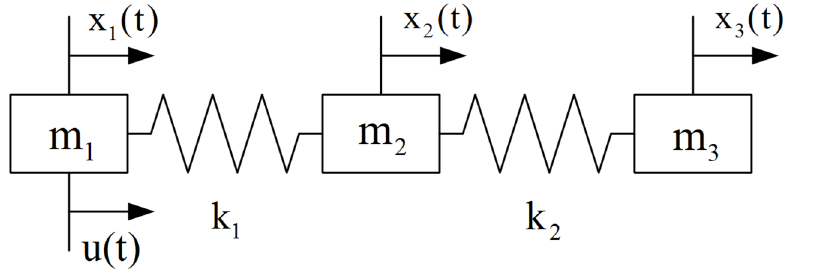
Fig 8. Three-mass-spring system.